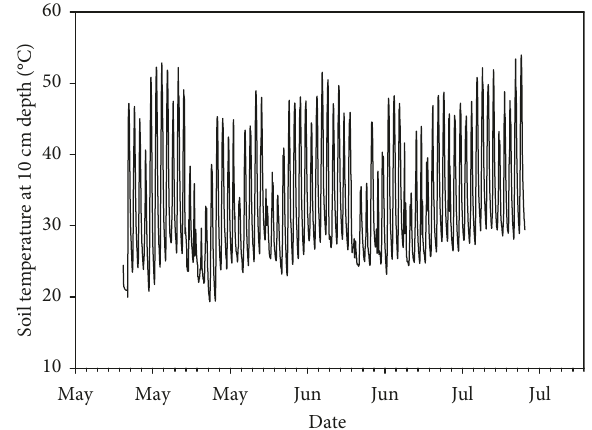
Figure 1: Soil biosolarization temperatures at a depth of